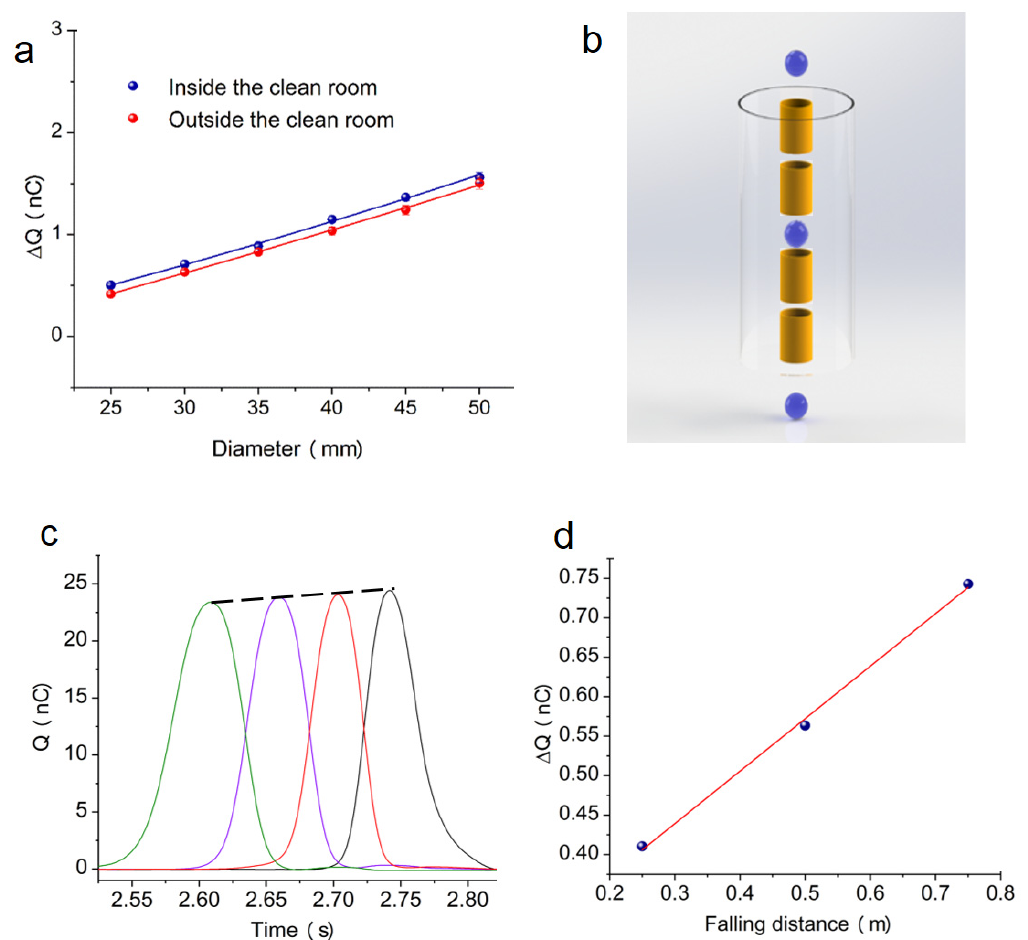
Figure 3. Effects of floating particles in the air and falling distance on gas–solid contact electrification. ( a ) The result of gas–solid electrification inside and outside the clean room. ( b ) The testing principle of different falling distances. ( c ) The output of the electrometer under different falling distances. ( d ) The relationship between the transferred charge and the falling distance.